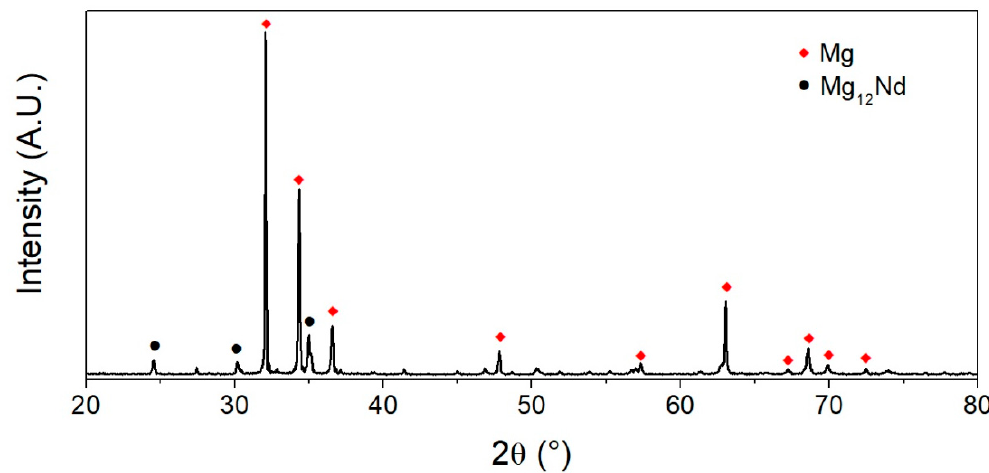
ff raction) pattern of EZ51 as-cast ingot (Cu-K α radiation). Metals 2019 , 9 , x FOR PEER REVIEW